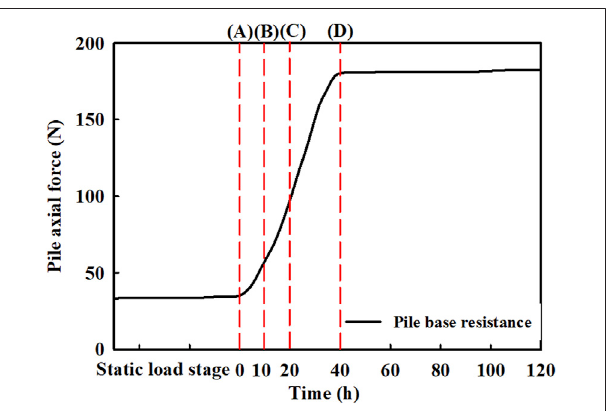
FIGURE 7 | Variations of pile base pressure with the time of